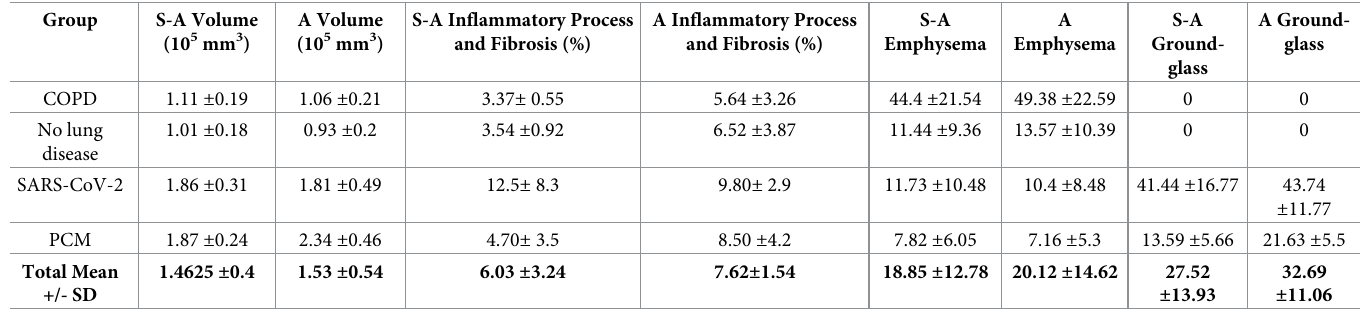
Table 1. Quantification values for semi-automatic (S-A) and automatic (A) algorithms, with mean and standard-deviation for lung volume, inflammatory process and fibrosis volume, emphysema volume, and ground-glass opacities volume. Group S-A Volume (10 5 mm 3